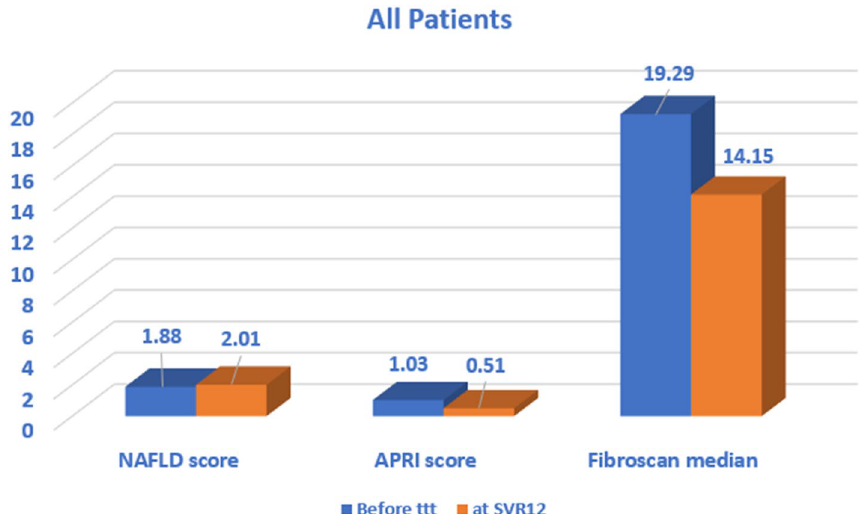
Fig. 5 Comparison between all patients in this study regarding NAFLD and APRI scores and FibroScan median before treatment and at